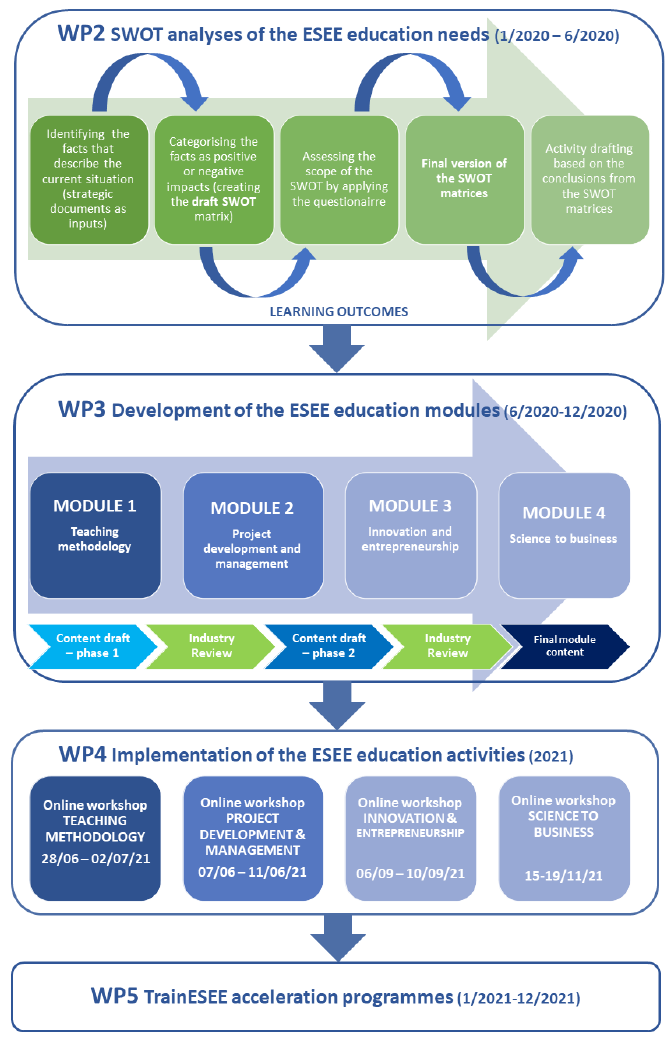
Figure 1. Overview of the methodological steps in project implementation.